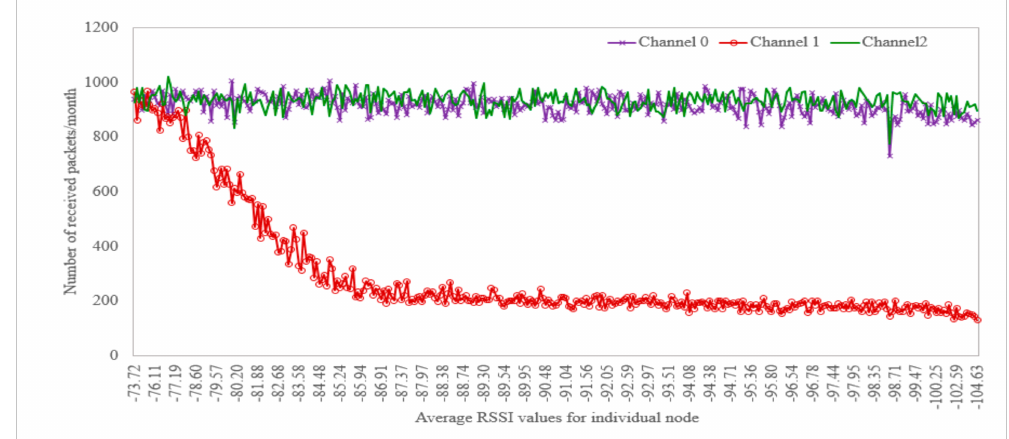
Figure 11. Average received radio signal strength and the number of received packets of an individual node for the di ff erent frequency